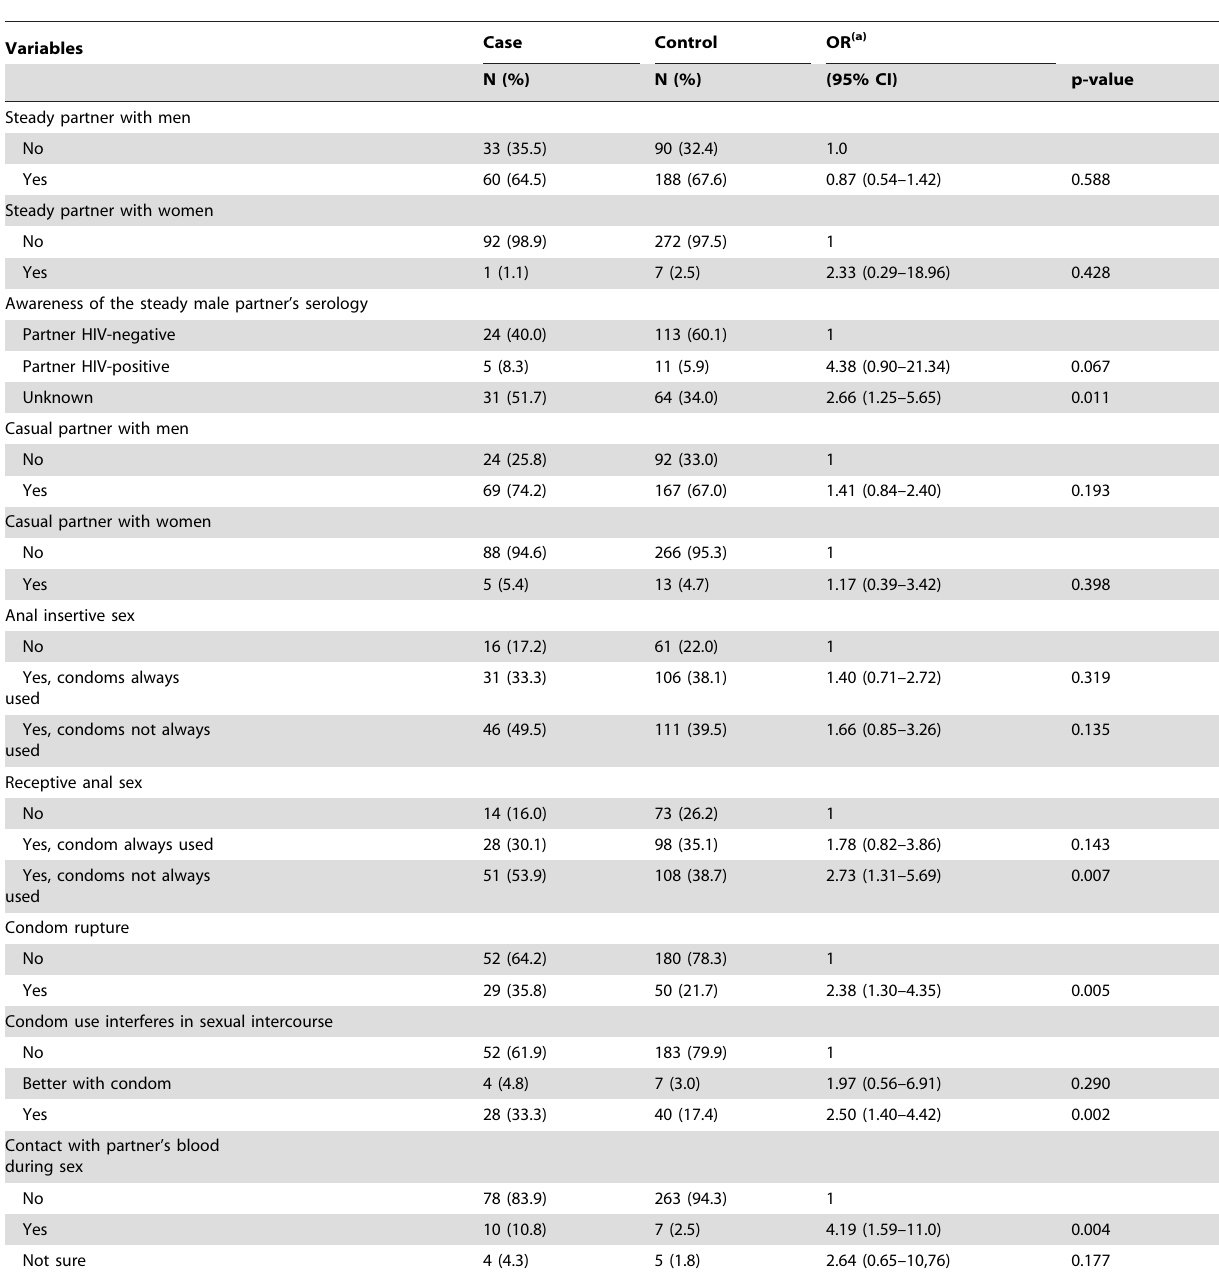
Table 2. Univariate analysis of sexual behavior, comparing HIV-positive and HIV-negative controls, Project Horizonte, 1994–2010.